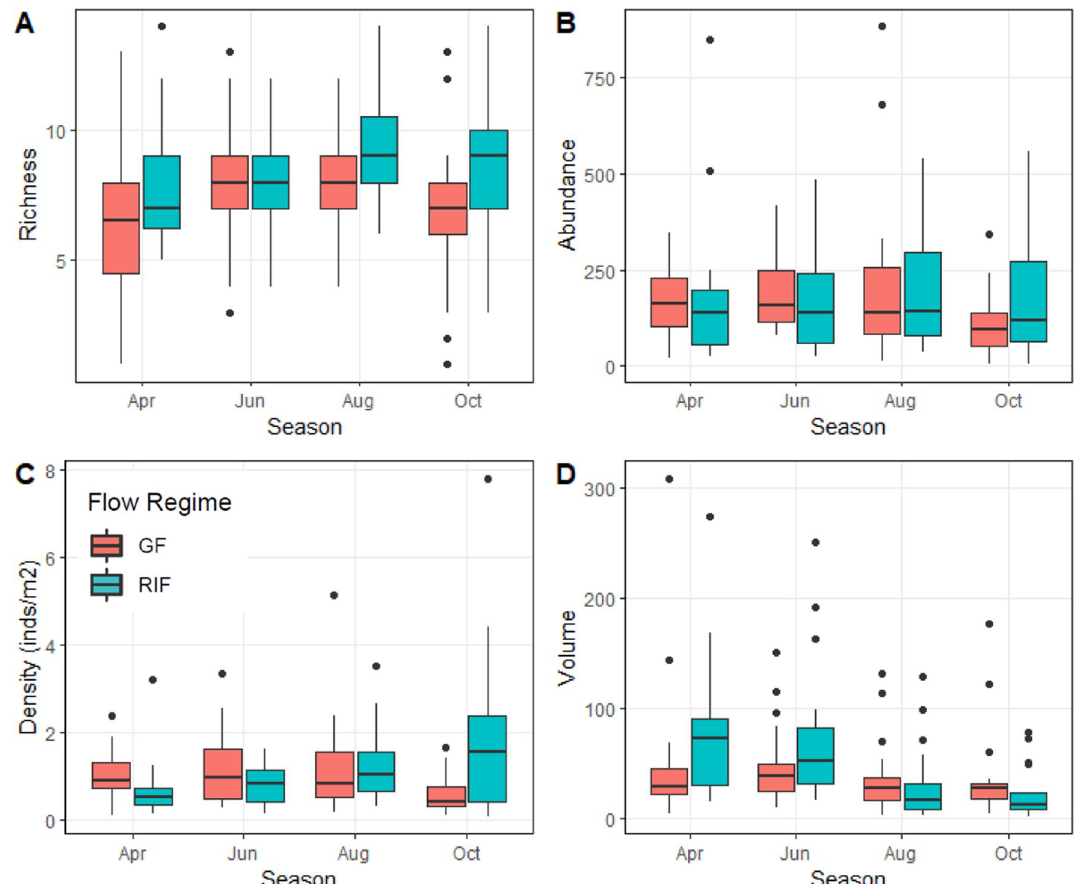
Figure 4. Boxplots of fish species richness ( A ), fish total abundance ( B ), fish total density ( C ) and ( D ) habitat volume (m 3 ) in Runoff/Intermittent Flashy (RIF) and Groundwater Flashy (GF) streams in 2003. Boxplots are as in Fig. 3. Figure produced with R 34